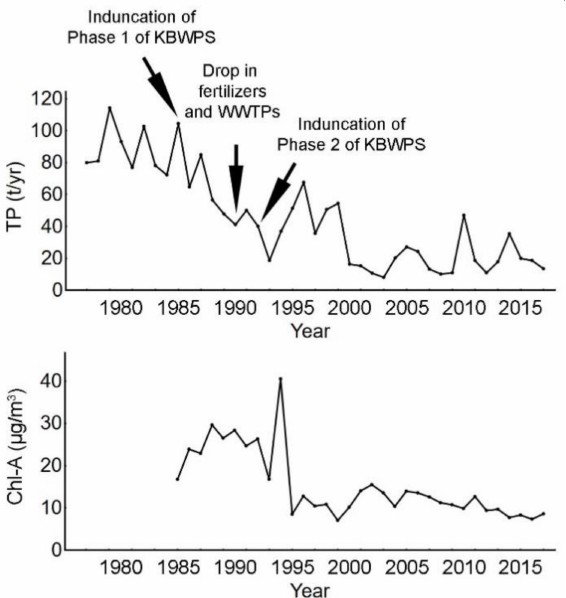
Figure 6. Average annual concentrations of total phosphorus (TP) and chlorophyll a (Chl-a) in Lake Balaton during the period from 1977 to 2017. Figure is based on that in Hatvani et al. [17] with permission from the